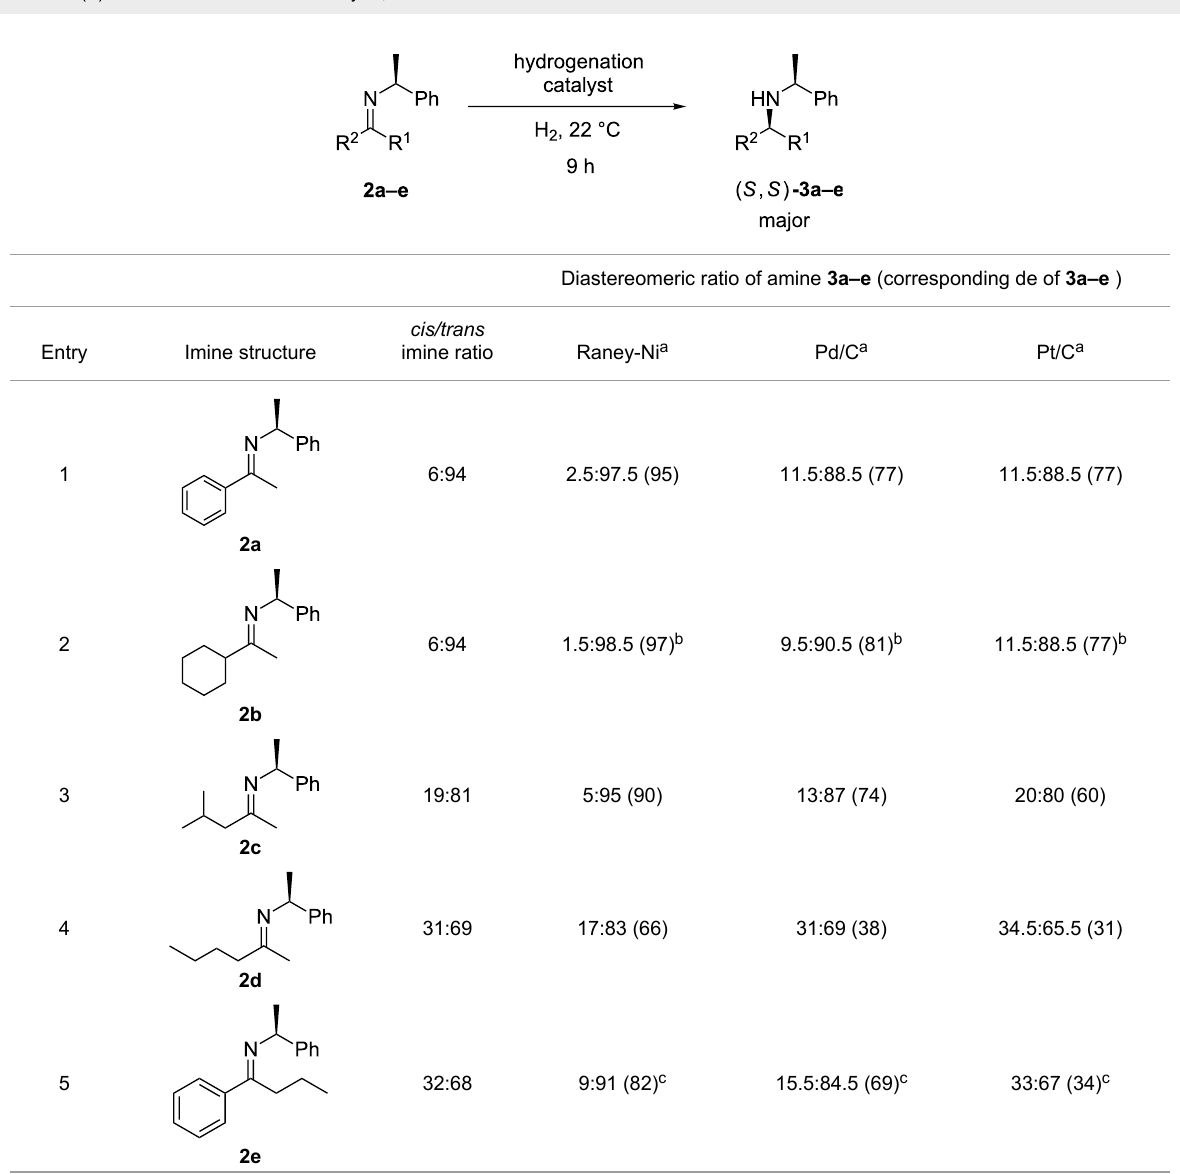
Table 2: ( S )-PEA imine reduction with Raney-Ni, Pd/C and